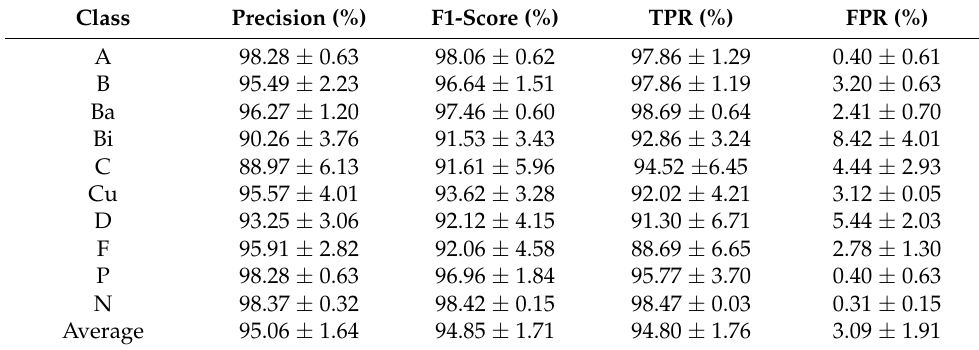
Table 7. Performance metrics of RNN 10-class